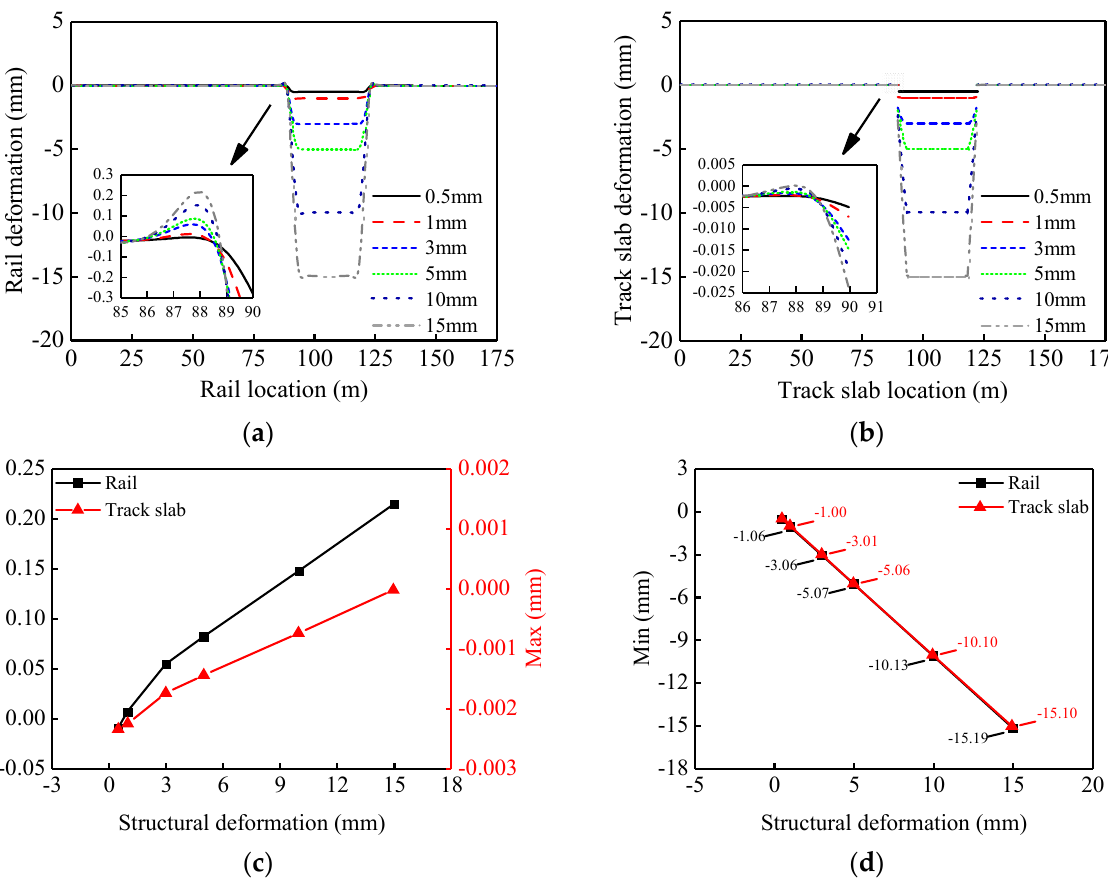
Figure 9. Variation of track vertical deformation with girder vertical fault: ( a ) vertical rail deformation; ( b ) vertical track slab deformation; ( c ) upward deformation of rail and track slab; ( d ) downward deformation of rail and track slab.